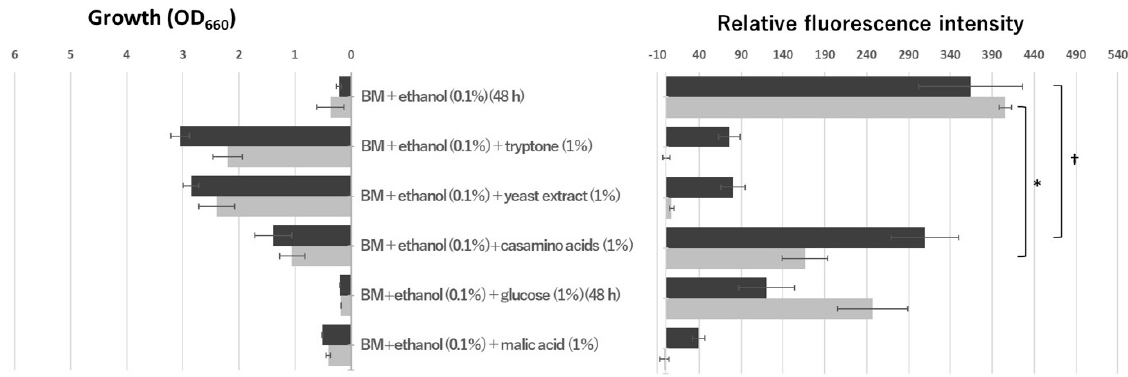
Figure 4. Effect of nutrients on the oligotrophic gene expression under ethanol-induced conditions. The fluorescence intensity of the cells was measured as described in the legend in Figure 2. The cultivation time was 24 h unless otherwise stated. Statistical differences were ascertained by Student’s t -test, * represents p < 0.05; † represents p > 0.09.